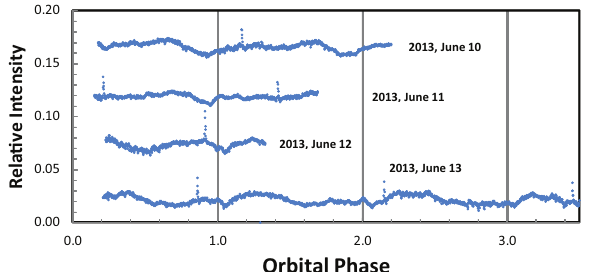
Figure 4: Optical photometry of UW CrB on four successive nights in June 2013 is shown, compared to star C in the finder chart of Hakala et al. (1998). The light curves taken on the first three nights have been shifted in intensity relative to the fourth by increments of 0.05. The phase and shape of the partial eclipses fluctuate over a 5.5 day beat cycle. See Mason et al. (2008, 2012) and Hakala et al. (2009).